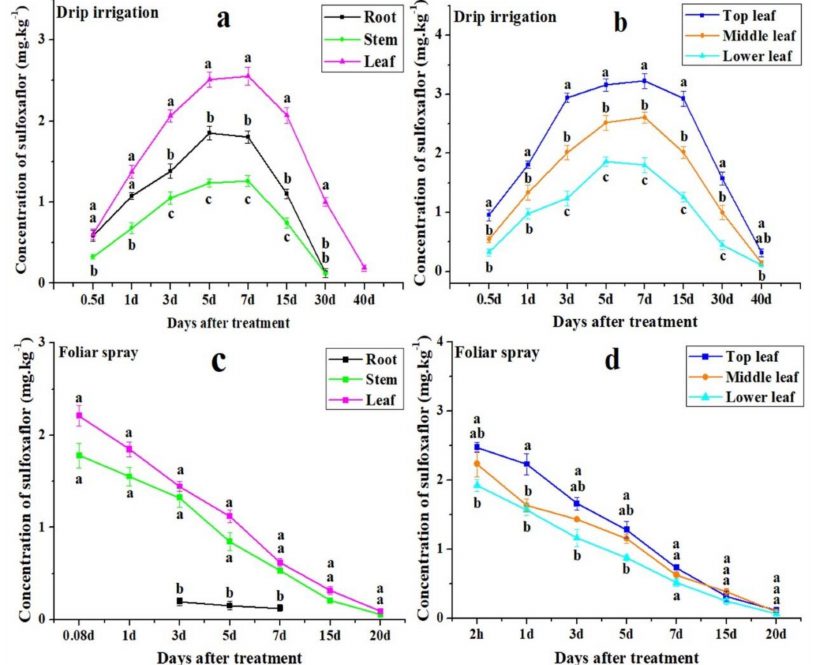
Figure 2. Distribution of sulfoxaflor applied through drip irrigation in roots, stems, and leaves ( a ) and in top, middle, and low leaves ( b ), and via foliar spray in roots, stems, and leaves ( c ), and in top, middle, and low leaves ( d ) in 2017. All data are expressed as mean ± S.E. (n = 3). Values within the same time period labeled with di ff erent letters are significantly di ff erent based on Tukey’s HSD test at p <